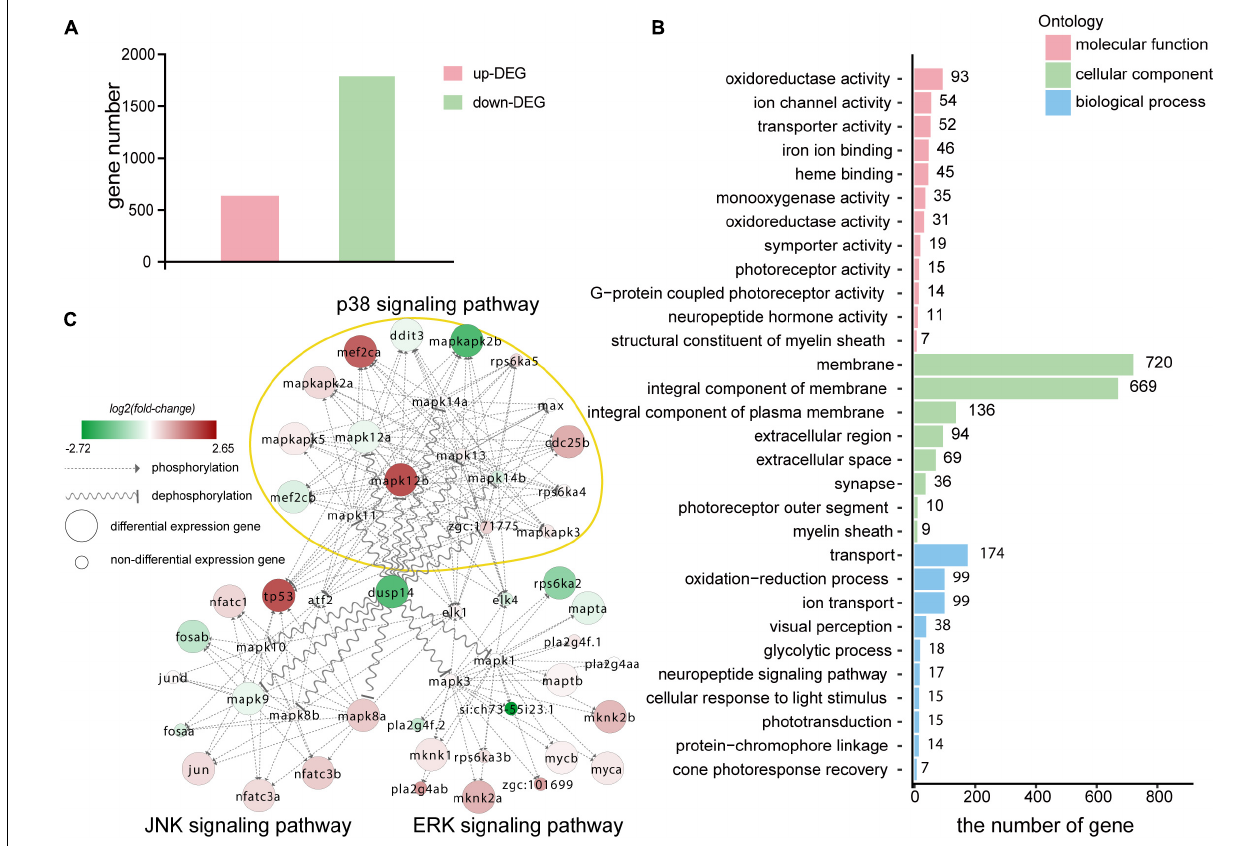
FIGURE 5 | Transcriptomic sequencing data revealed p38 signaling pathways may responsible for regulation of dusp14 gene on hearing function. (A) The upregulated differentially expressed genes (DEGs) and downregulated DEGs that might be affected by knockdown dusp14 based on transcriptome data analysis. (B) Gene ontology (GO) annotation enrichment of DEGs. (C) Gene expression changes in the MAPK pathway caused by dusp14 knockdown.